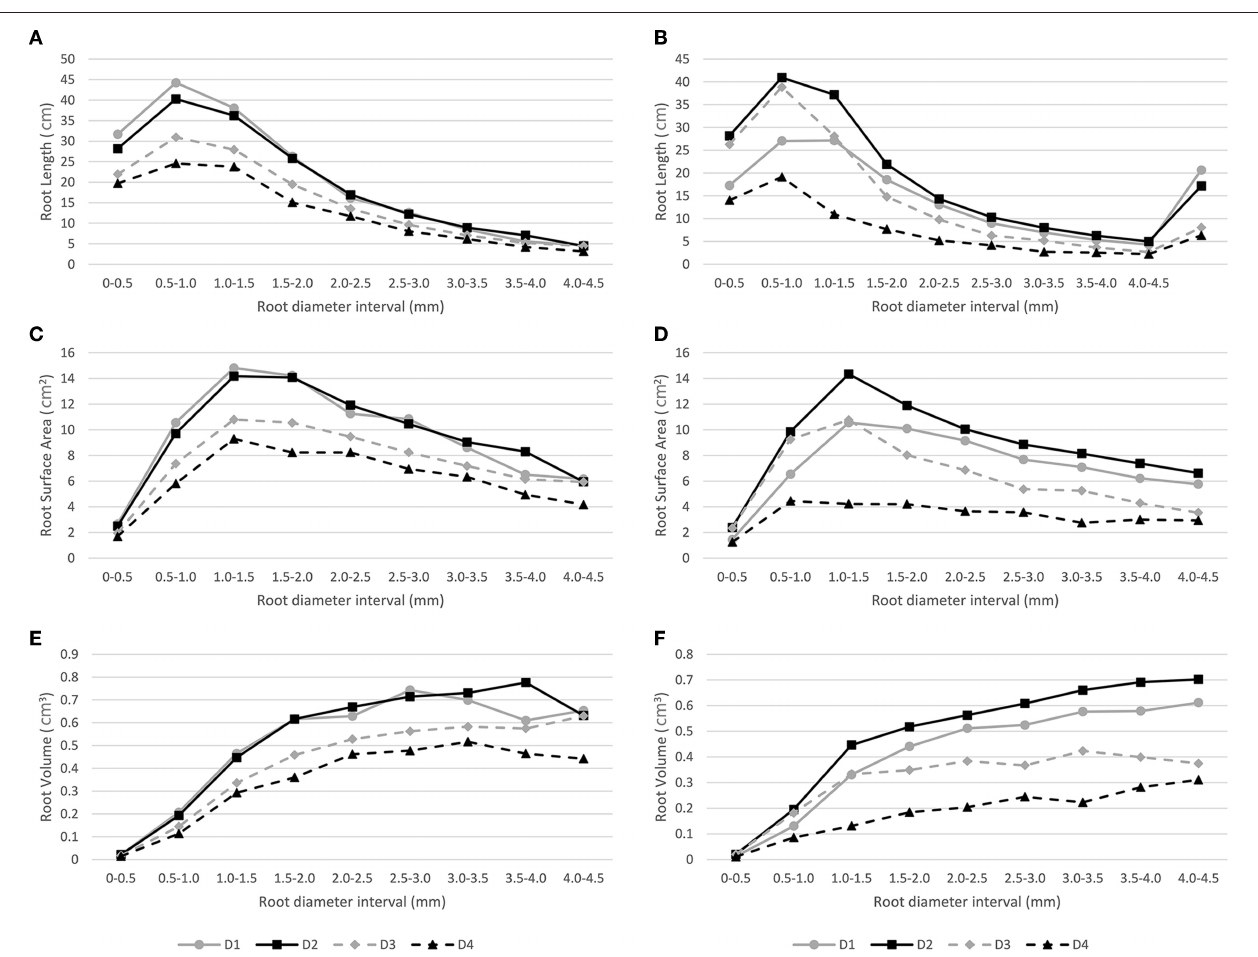
FIGURE 3 | Distribution of root traits (i.e., RL, Root length; RV, Root Volume; SA, Surface Area) across nine root diameter intervals under well-watered ( A,C,E , respectively) and water-deficit ( B,D,F , respectively) conditions in four depth substrate layers (D1: 0–10cm, D2: 10–20cm, D3: 20–30cm, D4: